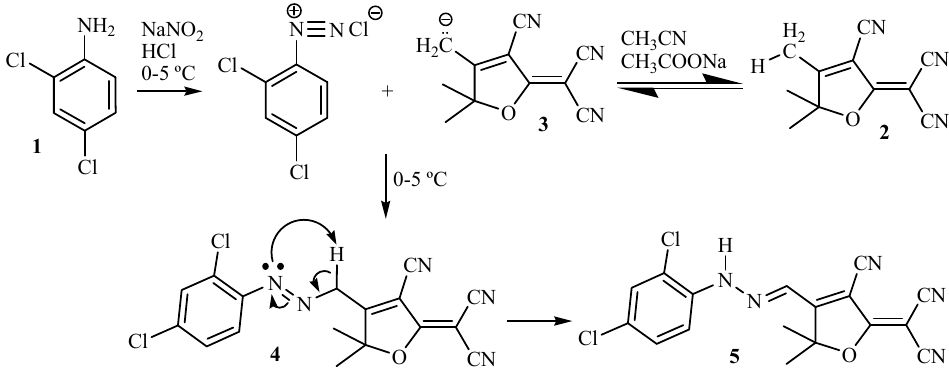
Scheme 2. Synthesis of dichlorophenyl-bearing dicyanomethylene dihydrofuran hydrazone